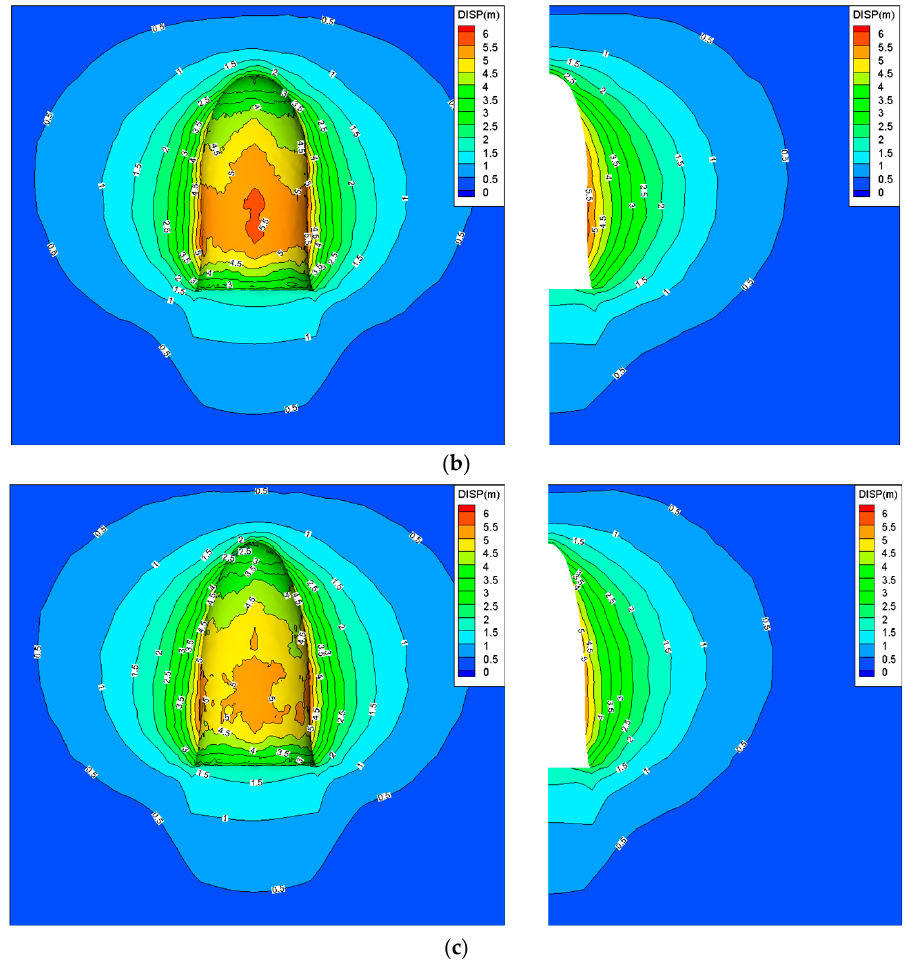
Figure 9. Displacement contours of the caverns with different upper shapes after operating for 30 years with an internal gas pressure of 14MPa. The right picture is a section of the center plane about the left picture. ( a ) 40 m, ( b ) 70 m, ( c ) 100 m.